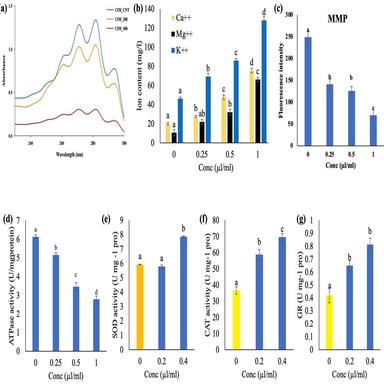
Mechanism of action: Effect of CIM on ergosterol (a) Reduction graph of ergosterol content (b) Leakage of ion content, (c) Mitochondrial membrane potential (Fluorescence intensity) (d) ATPase activity and oxidative stress defense (e) SOD (f) CAT and, (g) GR.